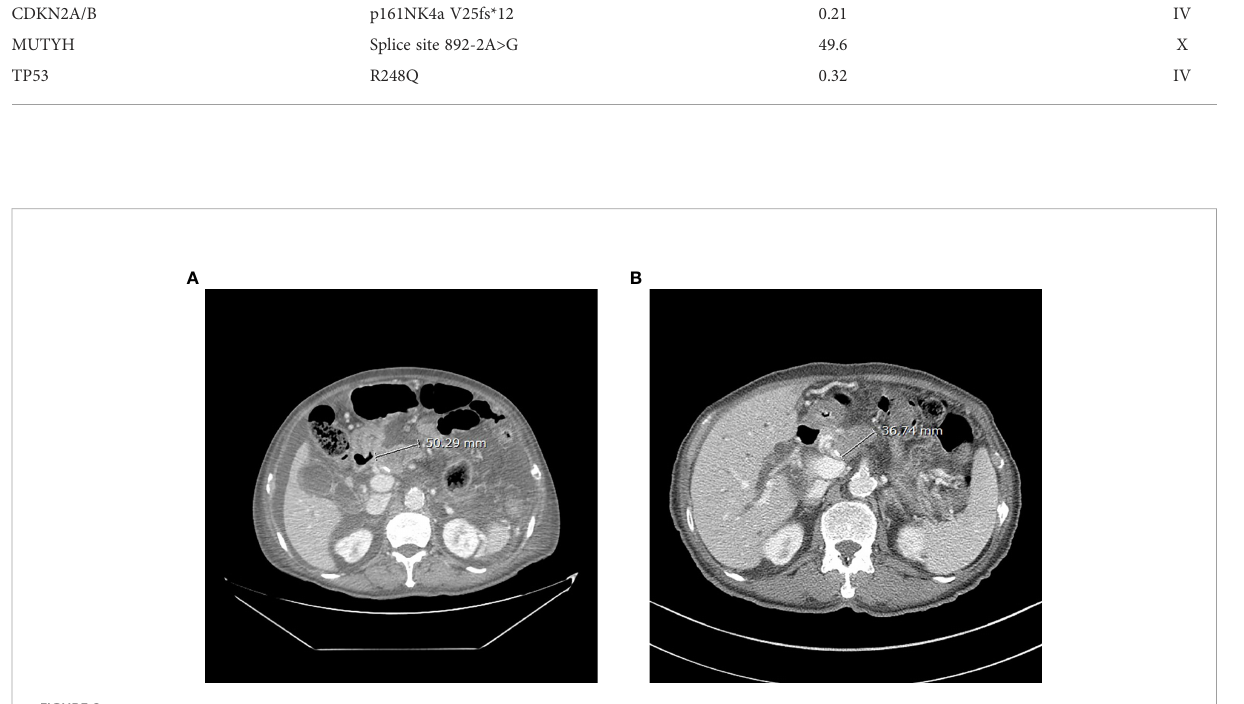
FIGURE 2 Abdominal CT of the patient before ( A , 7 July 2021) and after ( B , 6 September 2021) 8 weeks of dabrafenib use.